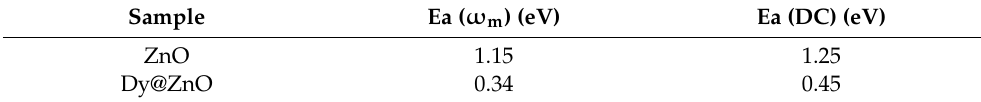
Figure 6. Angular frequency dependence of 𝜎 (cid:3021) conductivity at different temperatures for the pure ( a ) and Dy-doped ( b ) ZnO thin films. Table 3. The activation energy of the pure and Dy-doped ZnO layers. Table 3. The activation energy of the pure and Dy-doped ZnO